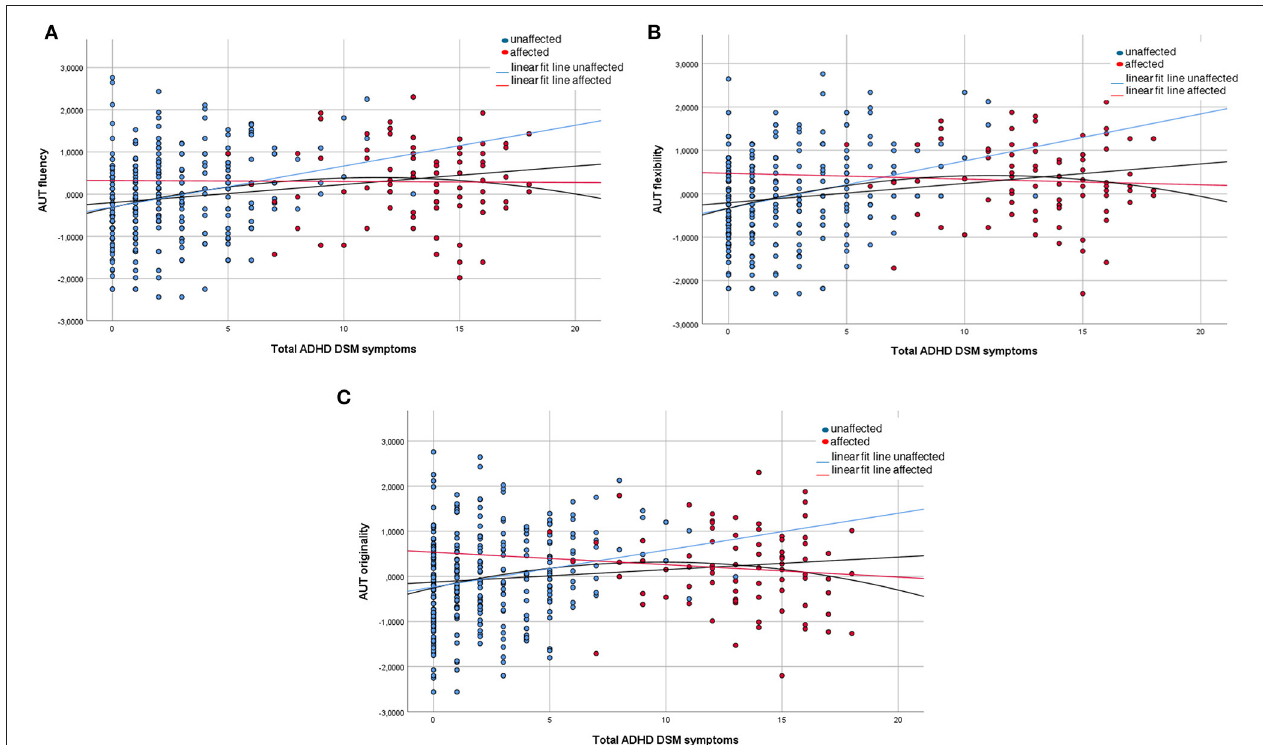
FIGURE 1 | Divergent thinking across the ADHD continuum. Displayed are the distributions of the fluency (A) , flexibility (B) , and originality (C) , subscores of the Alternative Uses Task, across the ADHD continuum in 215 subjects of the BIG study and 151 (79 cases and 72 controls) subjects of the IMpACT2 study. The blue dots represent the scores of the individuals without a diagnosis, the red dots represent the scores of the individuals with a diagnosis. The dark lines represent the linear and quadratic fit of the model for the combined datasets, the red line is the linear fit for the individuals with a diagnosis, and the blue line is the linear fit for the individuals with a